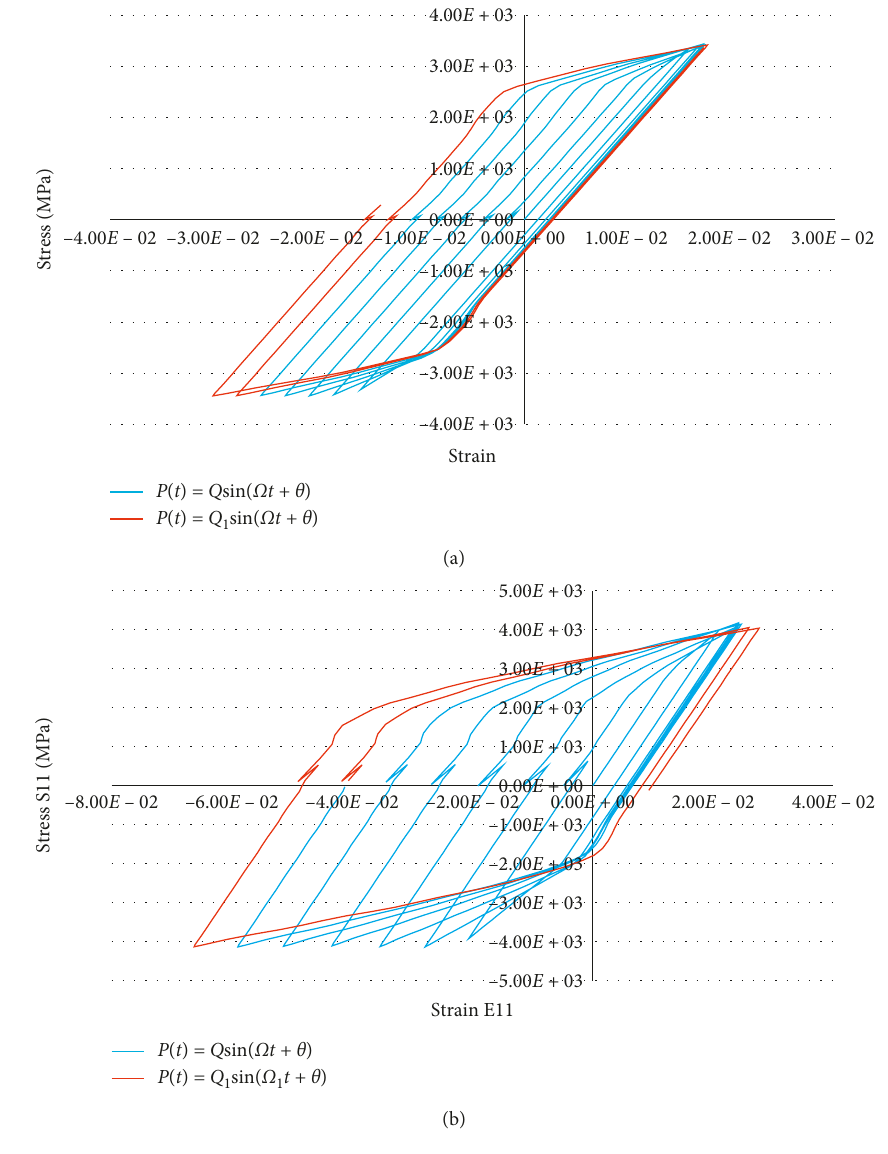
Figure 6: The hysteresis of 2 vibration amplitudes Q and Q